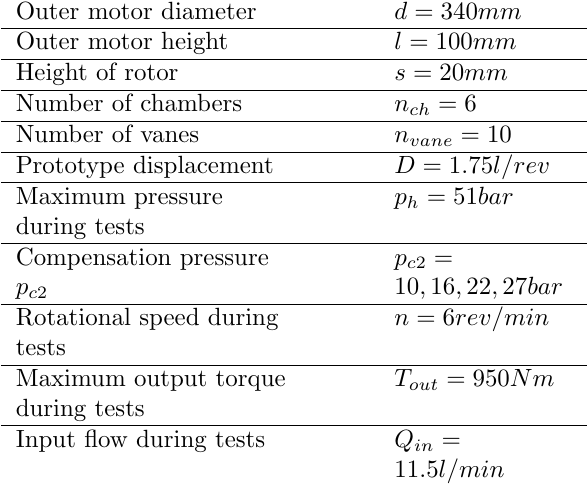
Table 1: The prototype specifications and the operat- ing conditions during the tests.